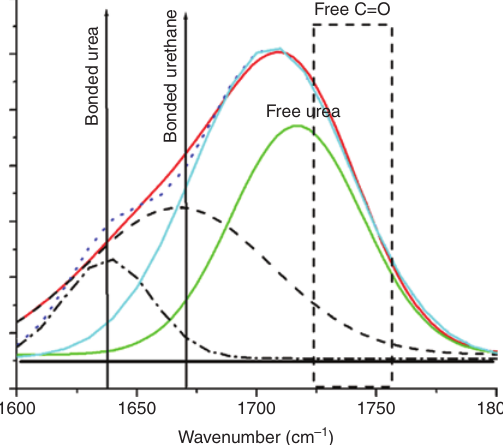
Figure 6: Representative deconvolution curve showing C = O zone for WPUDCO-1 polyurethane (PU)-prepolymer.